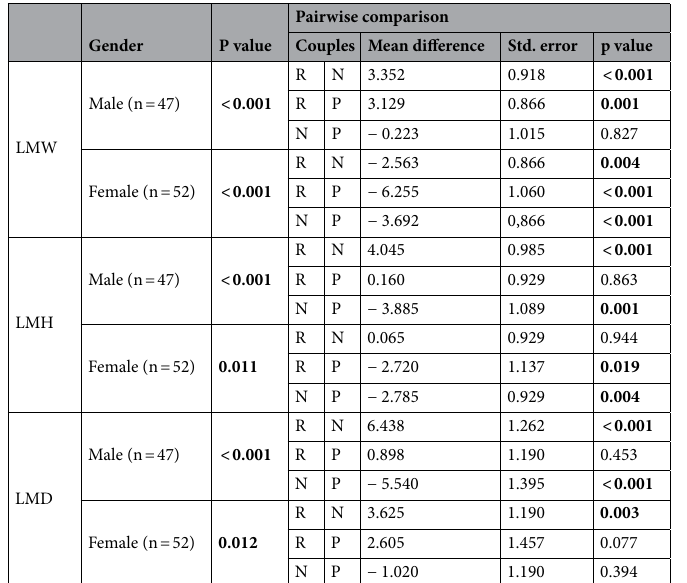
Pairwise comparison